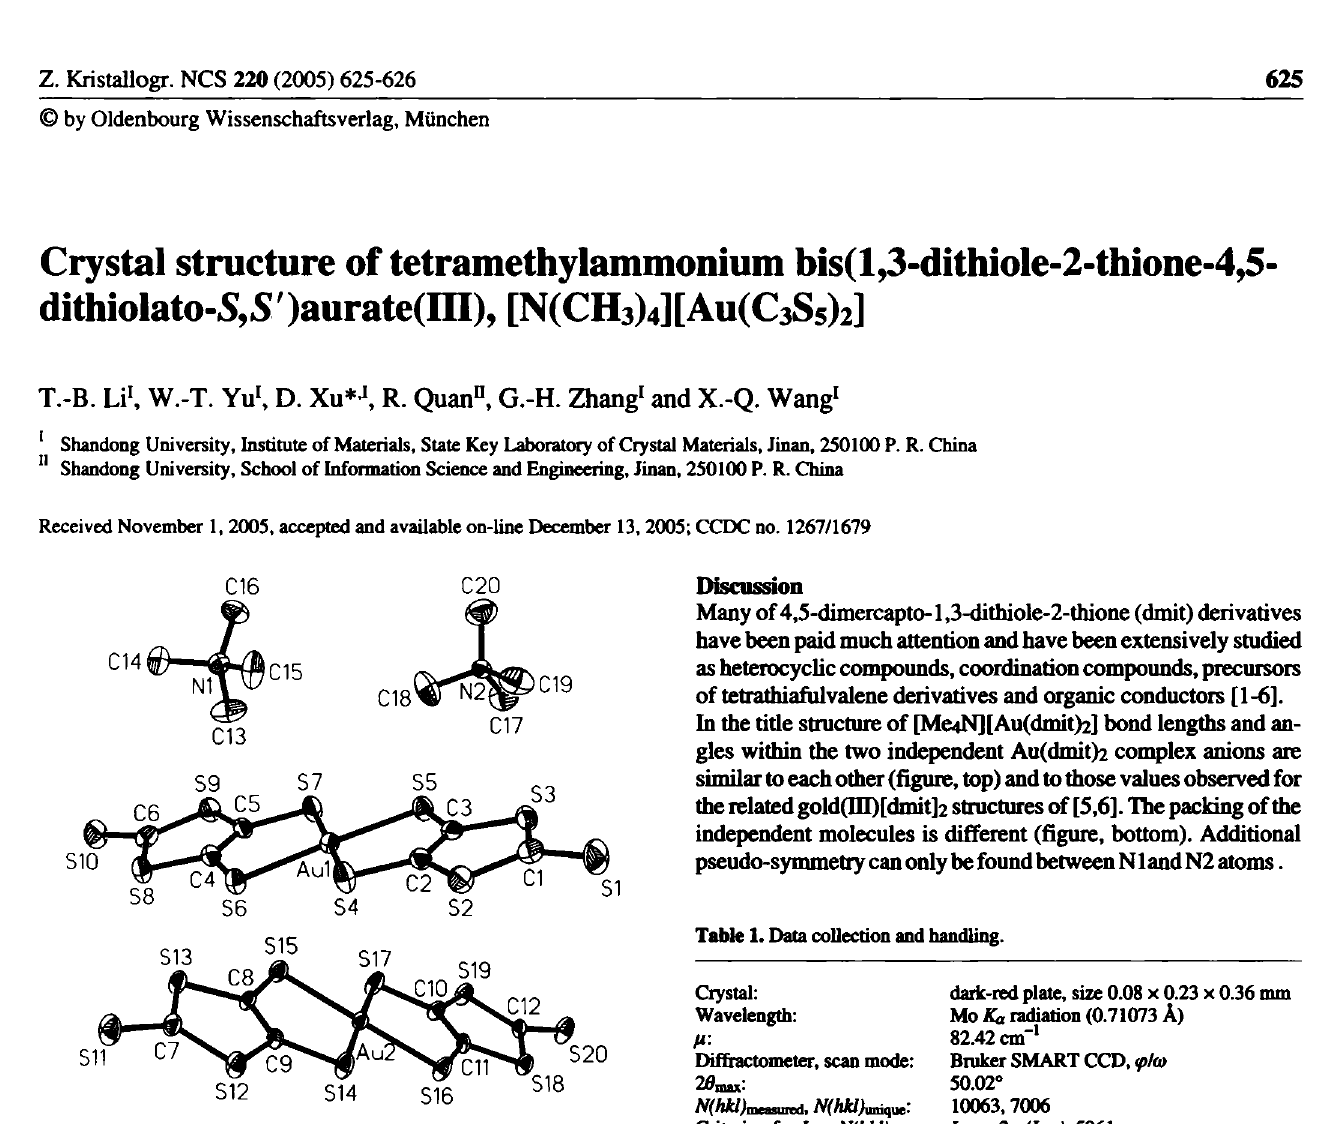
Table 2. Atomic coordinates and displacement parameters (in A 2